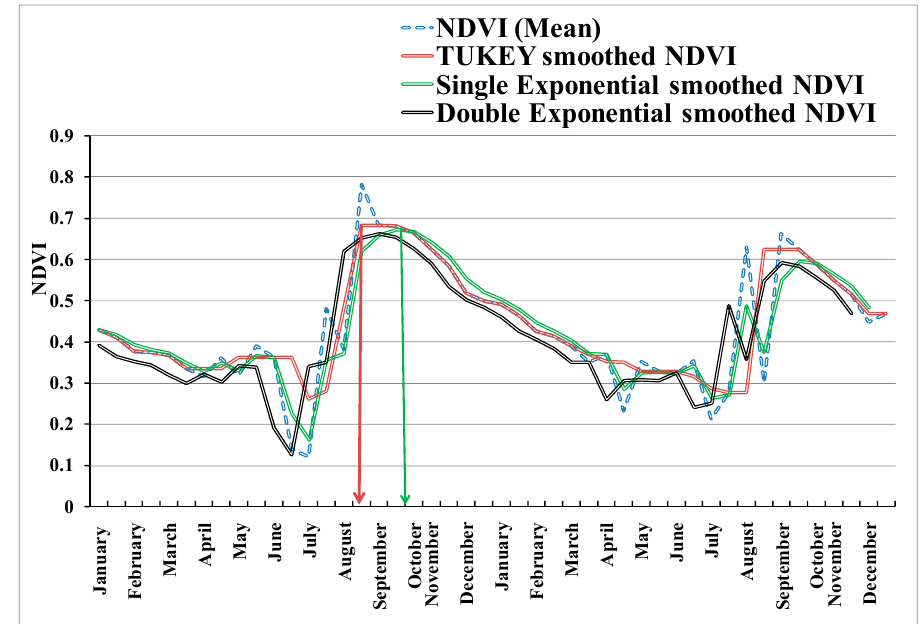
Figure 5. Different smoothing techniques’ utility in derivation of maximum of the season. Table 1. Phenological metrics derived using different data at different time periods.